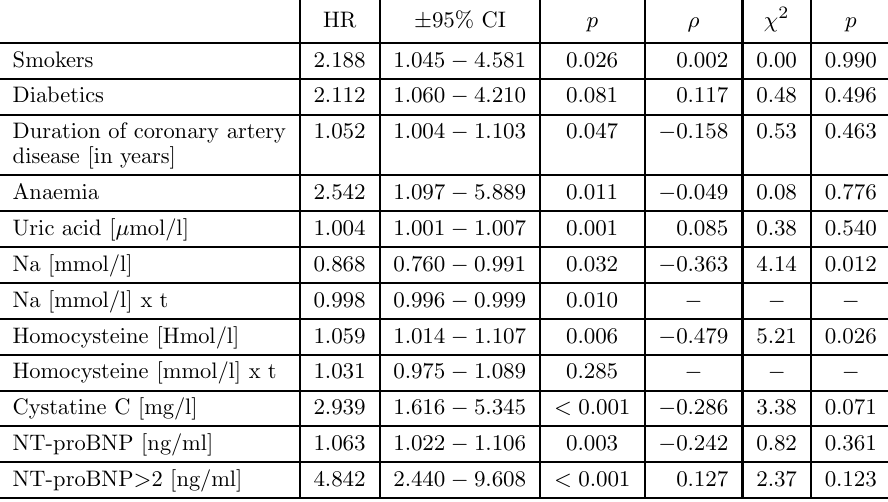
Table 4. Univariable analysis of Cox proportional hazards regression adjusted for age, statistically significant